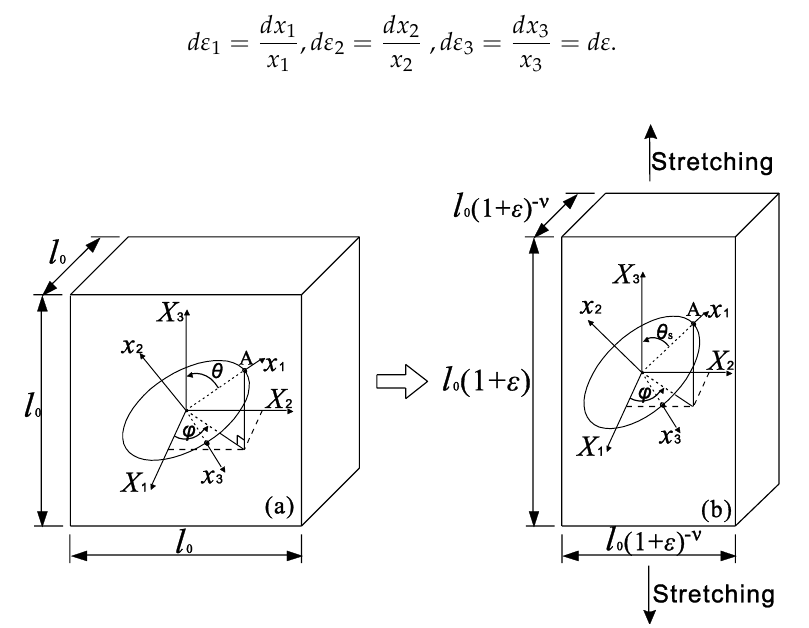
Figure 2. Reorientation of GPL in a cell subjected to uni-axial stretching.